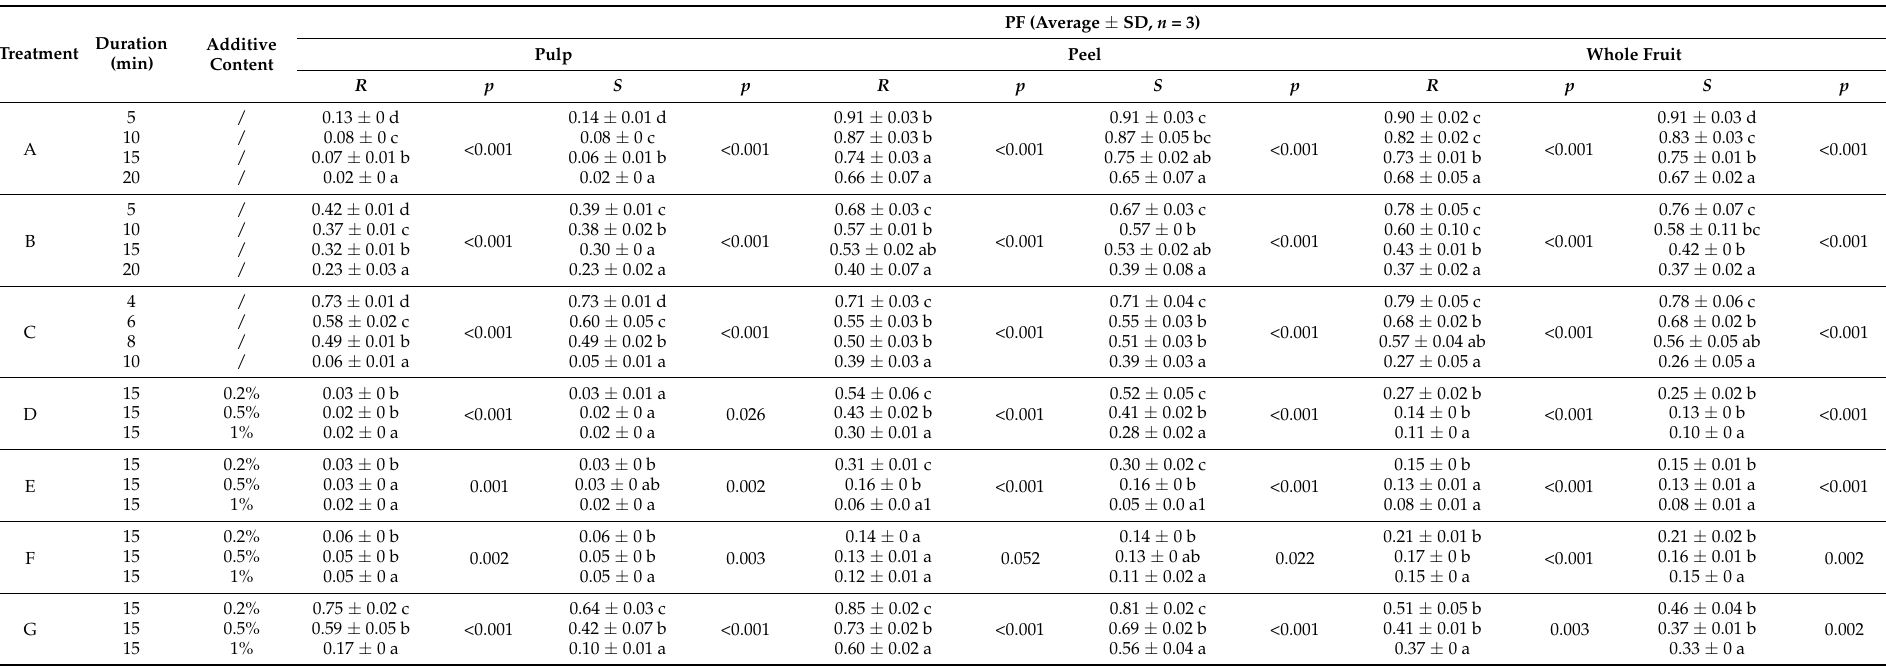
Table 1. Processing factor (PF) values of penthiopyrad enantiomers in tomato samples after different soaking